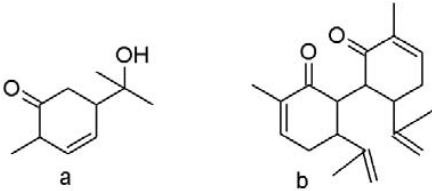
Figure 6. Undesired products identified in reaction mixture: 8-hydroxycarvone ( a ) and dicarvone ( b